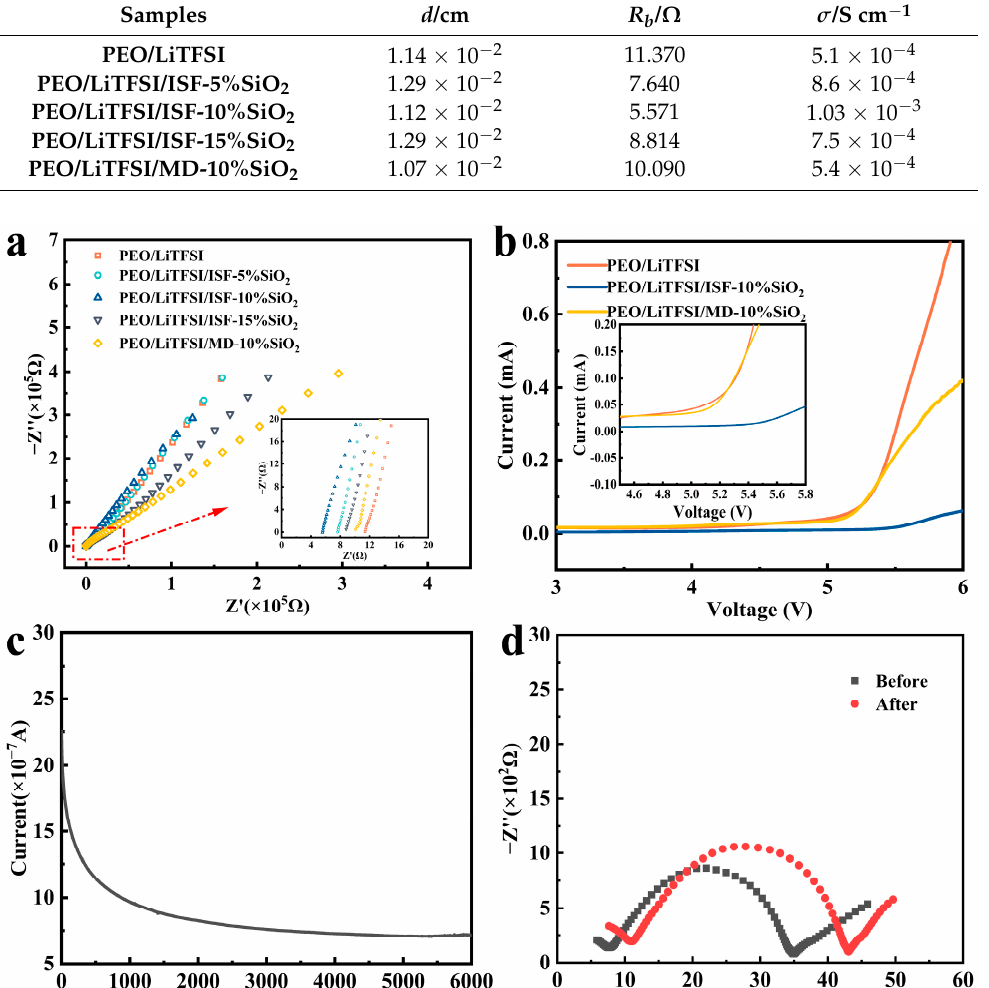
Table 3. The values of the ionic conductivity( σ ) for the electrospun SPEs. Samples